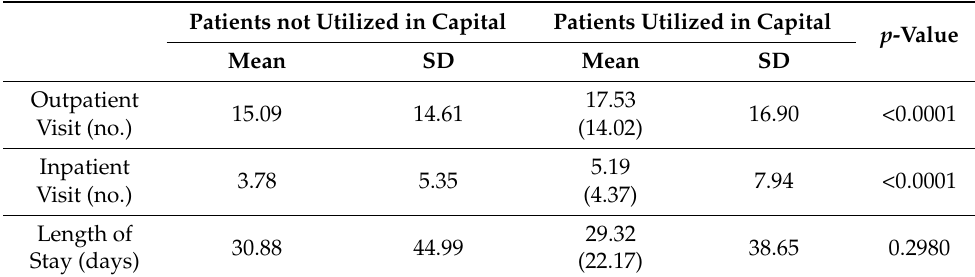
Table 3. Utilization volume of patients with cancer.